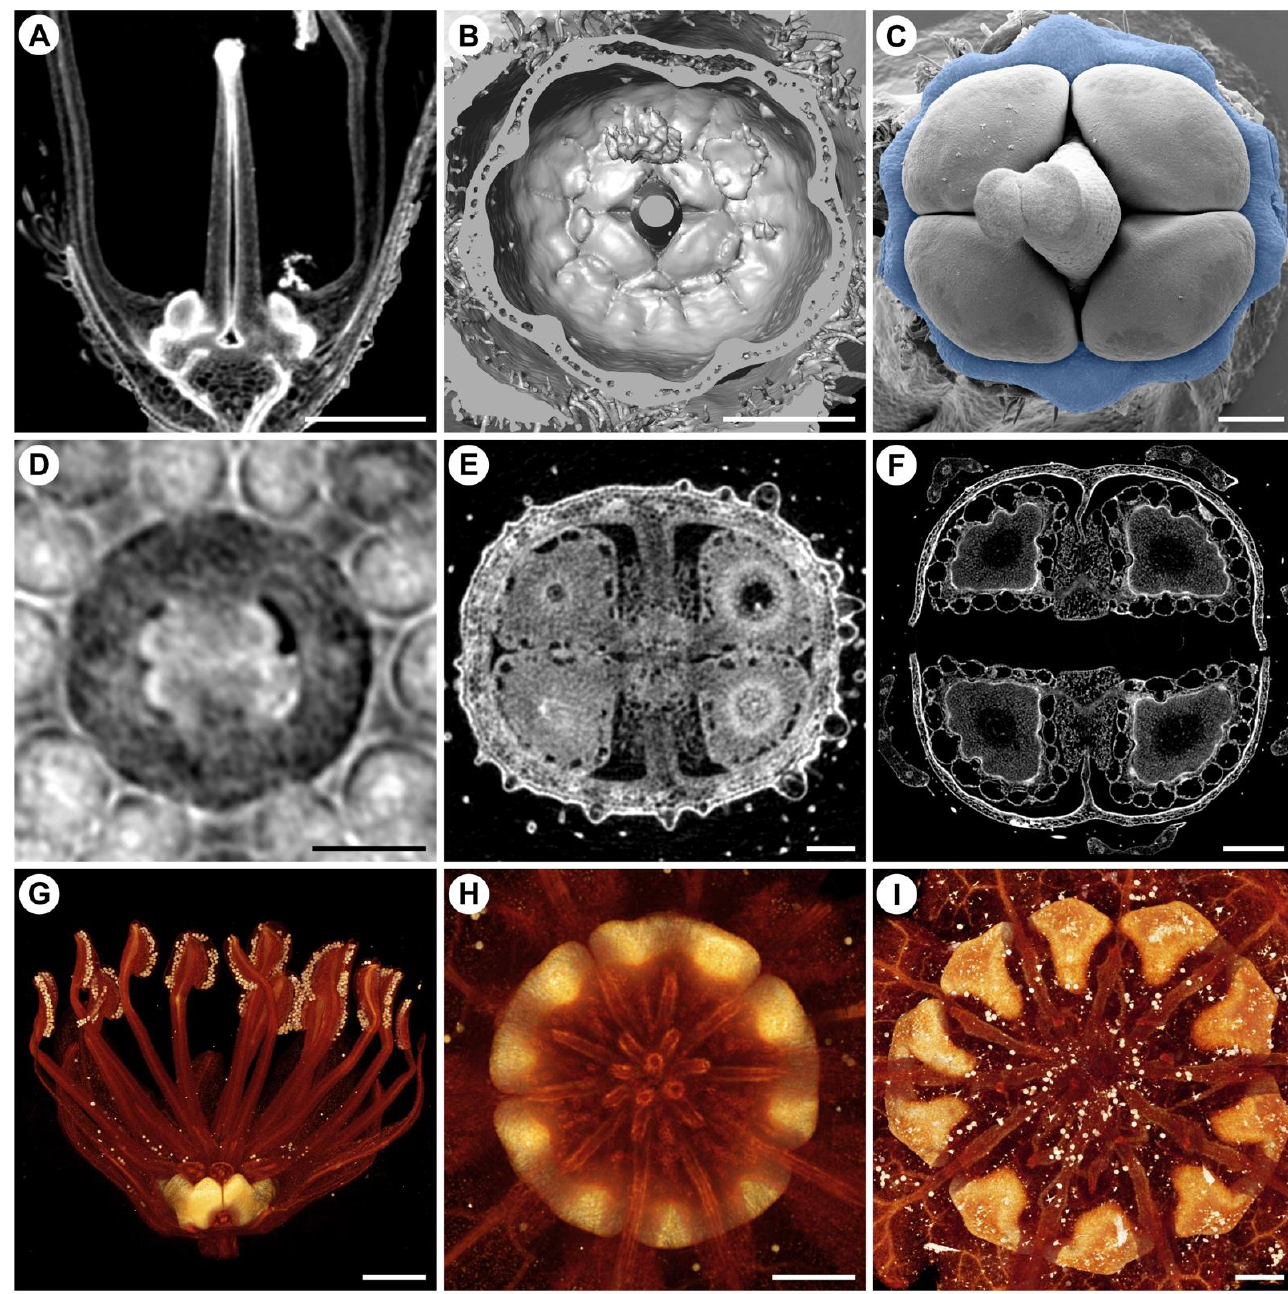
Figure 12. Flower structure and development visualized using µCT. ( A – C ) Myosotis sylvatica . ( A ) Virtual longitudinal section through an anthetic flower showing integration between nectary disc, mericarpids, and basal scales at base of corolla tube. ( B ) 3D-surface visualization of same data as A showing 10 basal scales enclosing ovary. ( C ) SEM image of gynoecium with lobed nectary disc highlighted in blue. ( D – F ) Phacelia malvifolia . ( D ) Virtual cross-section through young gynoecium at stage of ovule initiation. ( E ) Virtual cross-section through ovary at anthesis. ( F ) Virtual cross-section through mature fruit. ( G – H ) Croton chilensis . ( G ) 3D-volume rendering of virtual tangential-section through a staminate flower showing position of nectary glands between stamens and petals. ( H ) 3D-volume rendering of a staminate flower with upper part of stamens virtually removed. ( I ) C. alabamensis . Three-dimensional-volume rendering of a staminate flower showing presence of 10 nectary glands. Scale bars: G = 1 mm, A, B, F, H, I = 500 µm, C – E = 100 µm. A – C from Jeiter et al. (2020; published by Oxford University Press in Botanical Journal of Linnean Society, Volume 193, Issue 1,